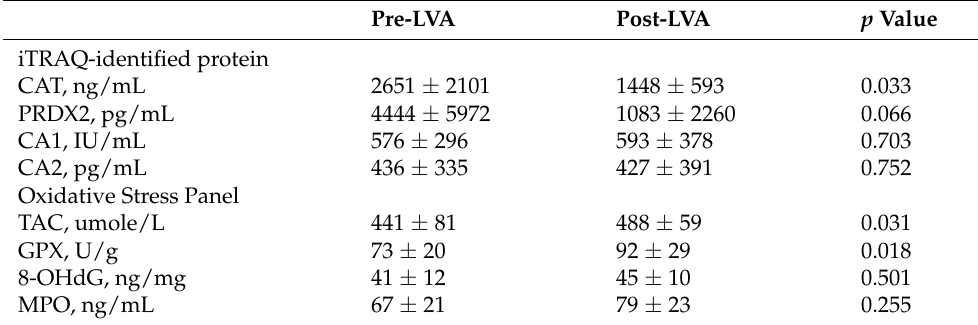
Table 2. Change of iTRAQ-identified serum proteins and oxidative stress markers following lym- phaticovenous anastomosis (LVA).